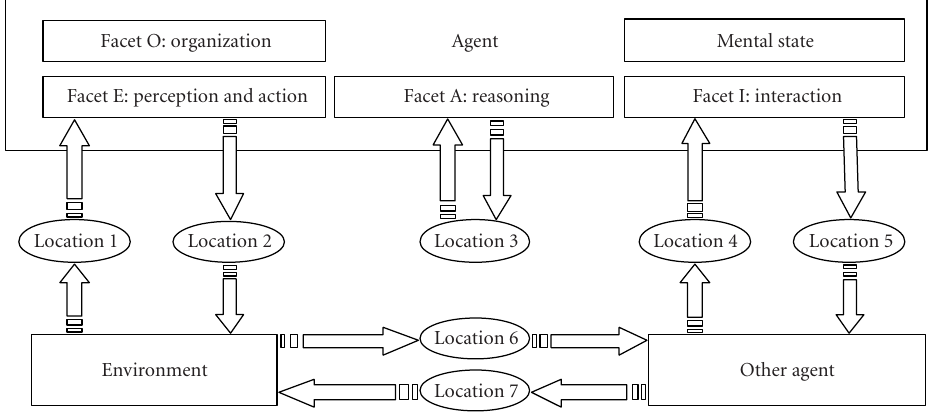
Figure 6: AEIO facets within an agent. The locations represent states, resources, or threads containing data. An output arrow from a location to an agent gives an observation of the data, while an input arrow leads to generation of data.